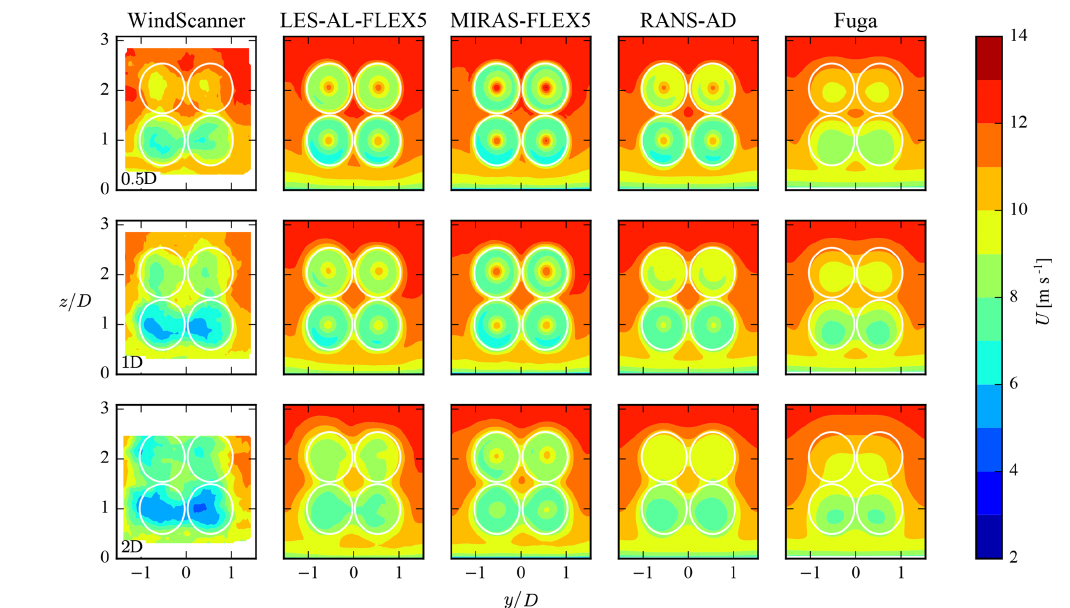
Figure 12. Near-wake case: contours of stream-wise velocity at three downstream distances.